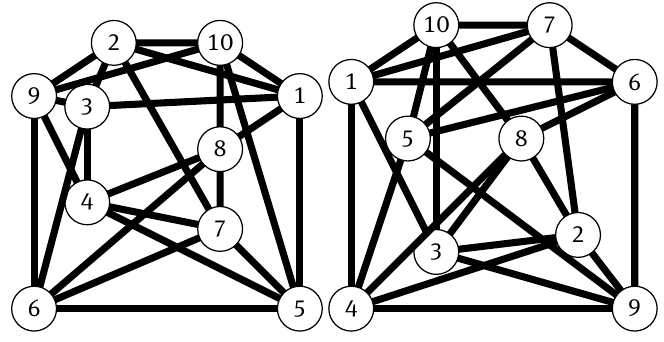
Figure 9: L 1 and L 2 , Graphs that are M cospectral for M = A , L , Q , L , D , D L , D Q and D